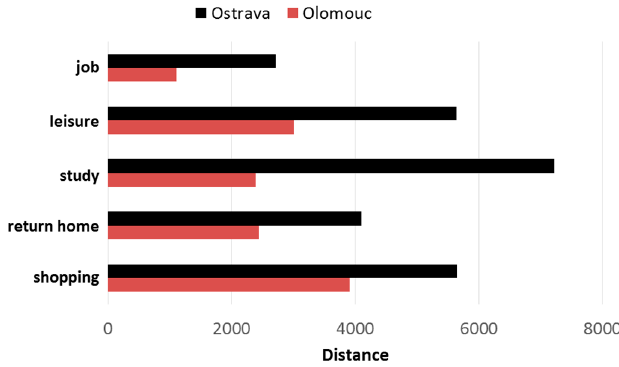
Figure 6. Average length (in metres) of routes according to purpose in Olomouc and Ostrava.